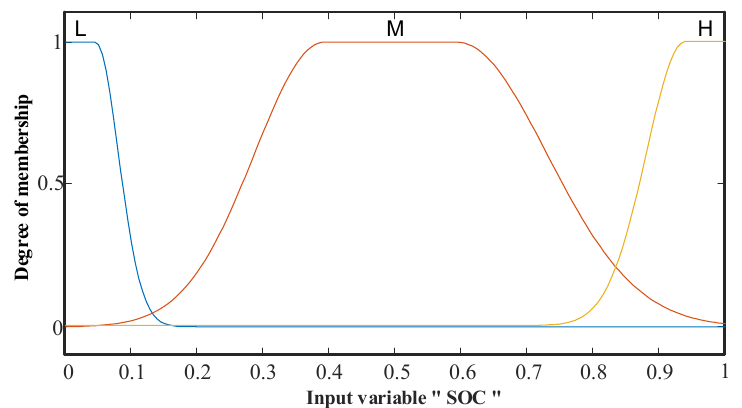
Figure 9. SOC membership function.